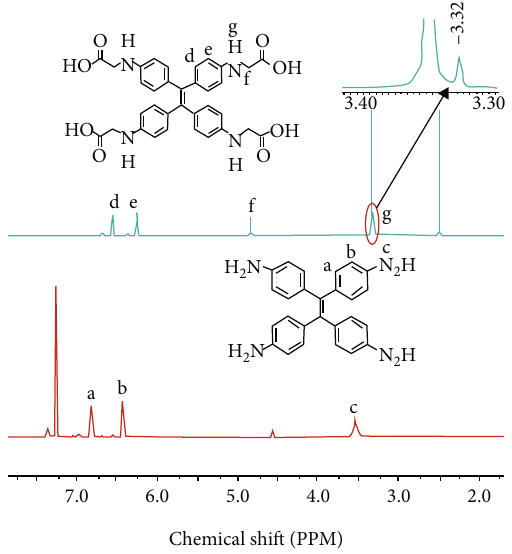
Figure 1: 1 H NMR spectrum of TPE-(N-COOH) (up) and TPE-AM in CDCl